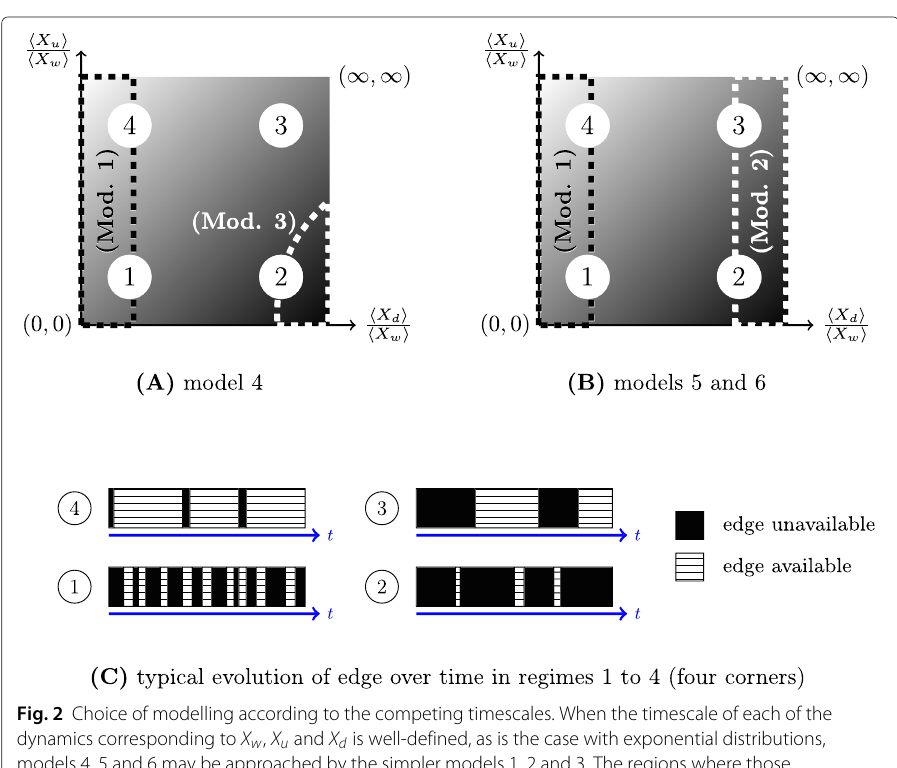
Fig. 2 Choice of modelling according to the competing timescales. When the timescale of each of the dynamics corresponding to X w , X u and X d is well-defined, as is the case with exponential distributions, models 4, 5 and 6 may be approached by the simpler models 1, 2 and 3. The regions where those approximations are valid are indicated on panel ( a ) for model 4, and on panel ( b ) for models 5 and 6. Panel ( c ) depicts a representative evolution over time of the state of the edges, in the four regimes corresponding to the corners of the domains of panels ( a ) and ( b ). This qualitative idea of equivalence between models is revisited more rigorously in Fig.